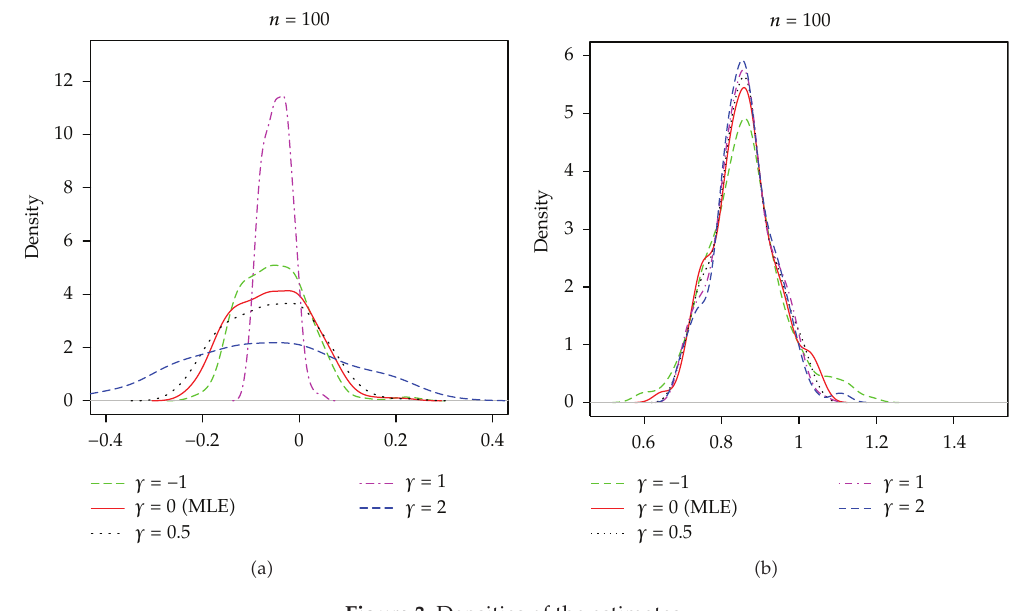
Figure 3: Densities of the estimates.